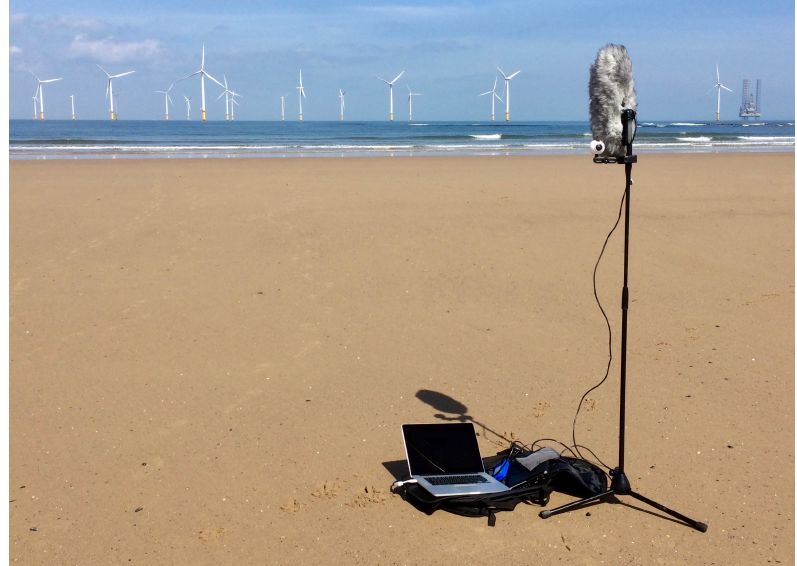
Figure 1. The setup used to record the EigenScape database: mh-Acoustics Eigenmike within a Rycote windshield, a Samsung Gear 360 camera, an Eigenmike Microphone Interface Box, and an Apple MacBook Pro. The equipment is shown here at Redcar Beach, UK: 54°37 (cid:48) 16 (cid:48)(cid:48) N, 1°04 (cid:48) 50 (cid:48)(cid:48)